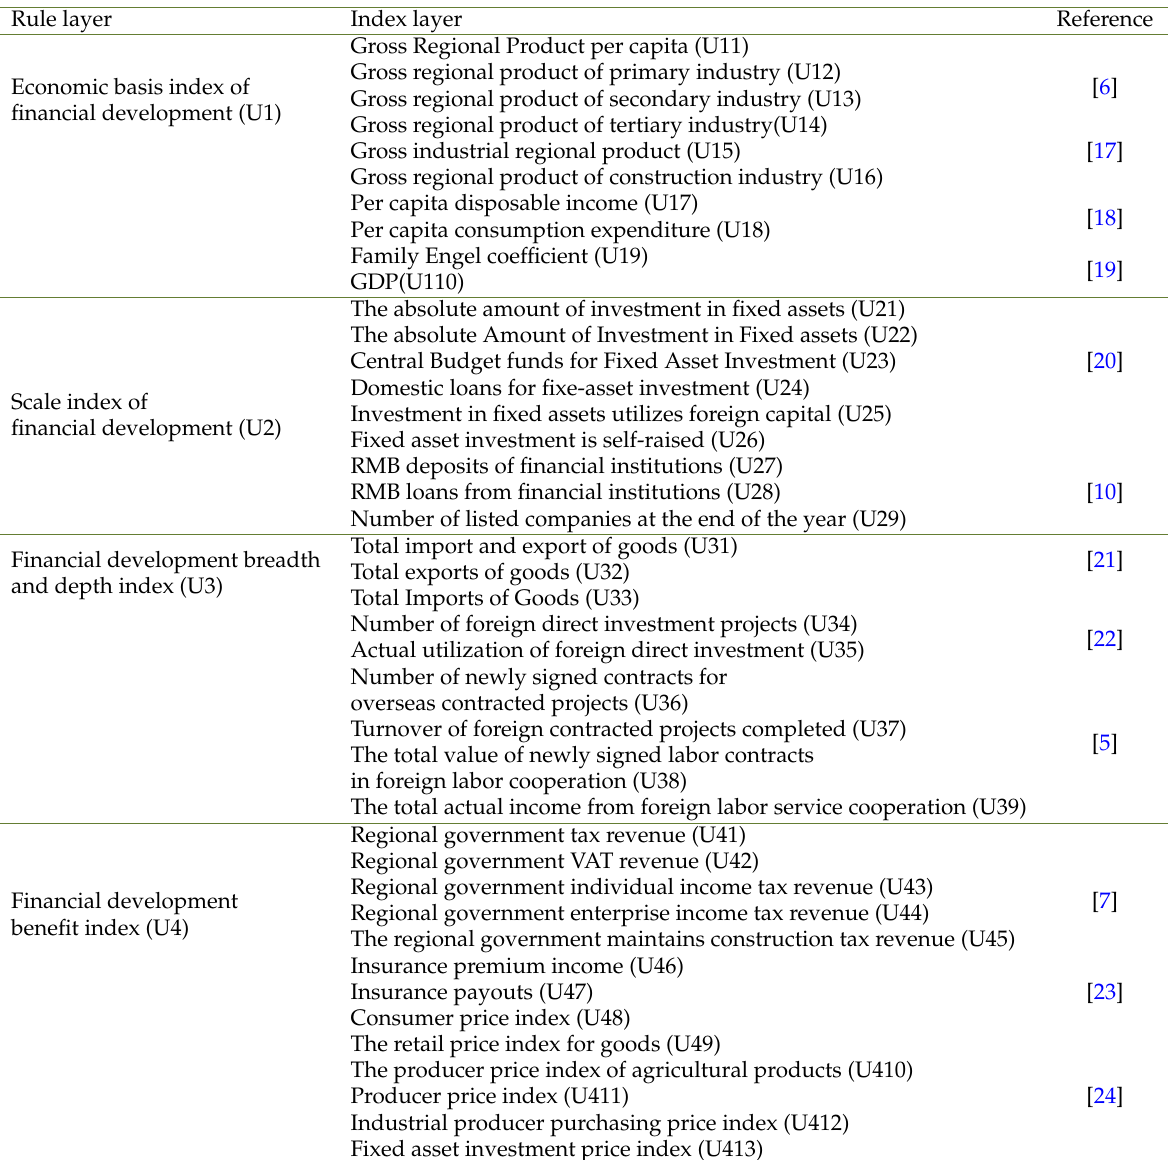
Table 1. Financial development index